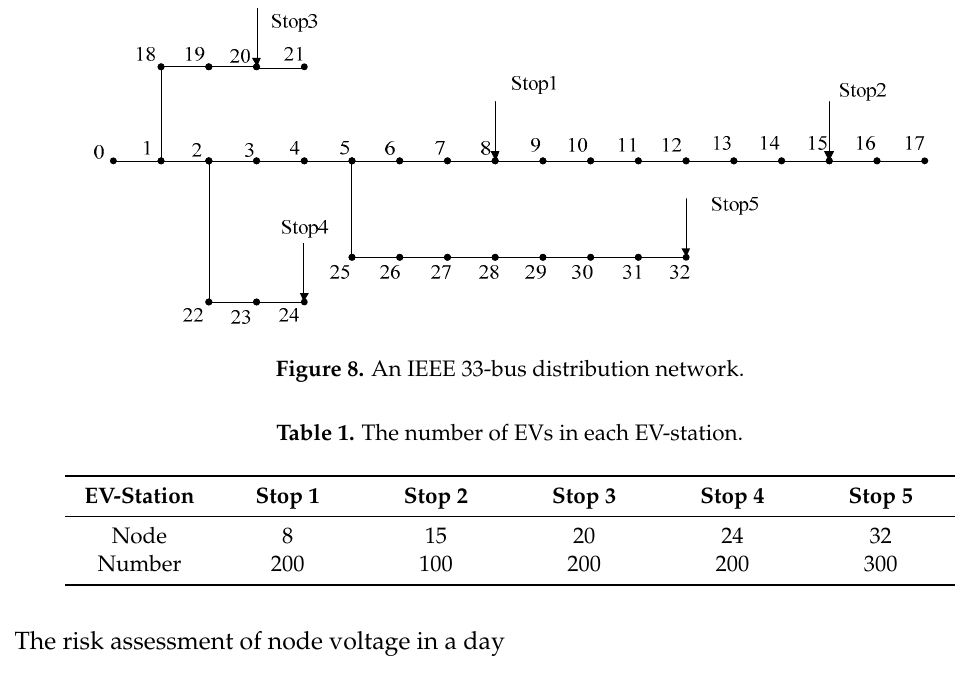
Figure 7. Active power loss curves of power distribution network in different cases.